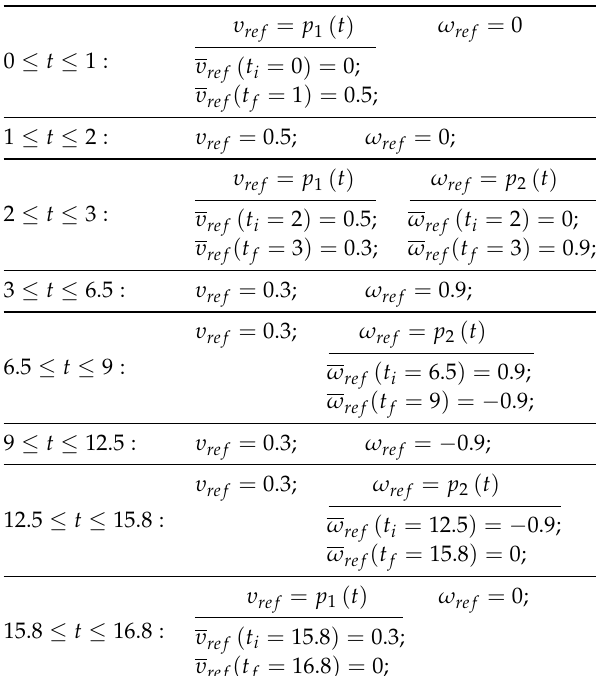
Table 1. Desired trajectory defined by Bézier.